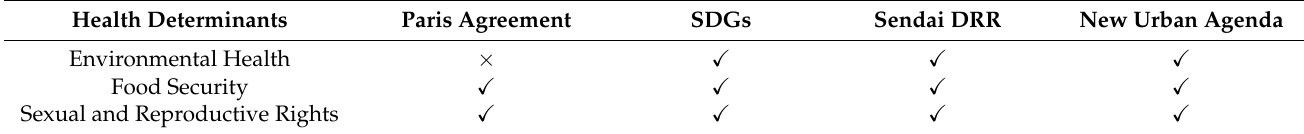
Table 4. Analysis of health determinants across all four agreements.